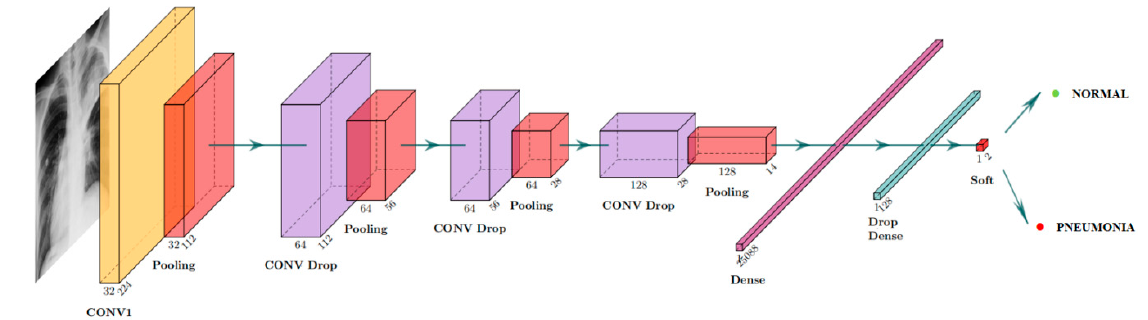
Figure 5. Details of proposed DL model.